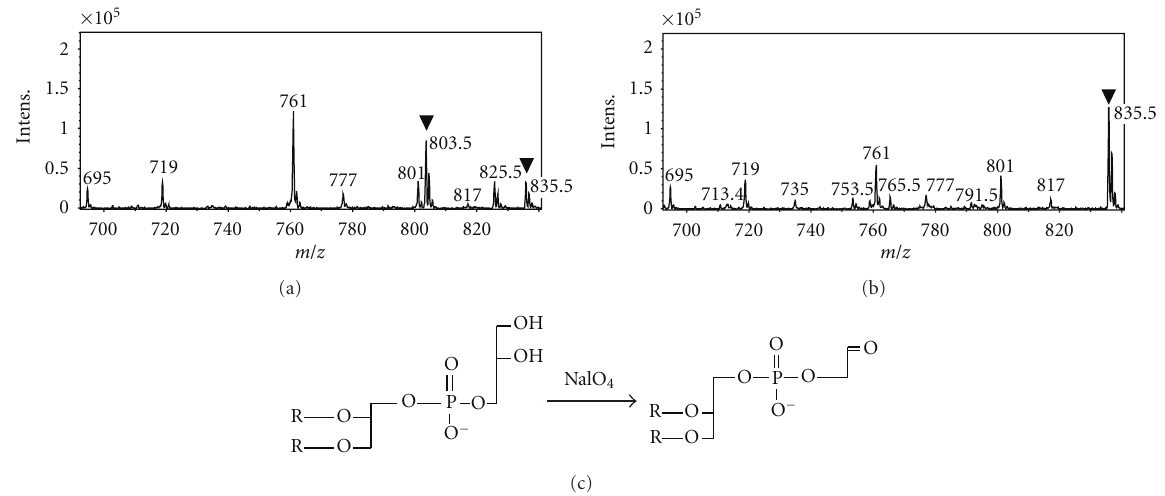
Figure 4: Sodium periodate treatment of DGGGP-Gro. (a) Positive ion spectrum from LC/ESI-MS analysis of the archaeal-type phospholipid postperiodate treatment and (b) preperiodate treatment. (c) The scheme of periodate treatment of DGGGP-Gro. R represents a geranylgeranyl